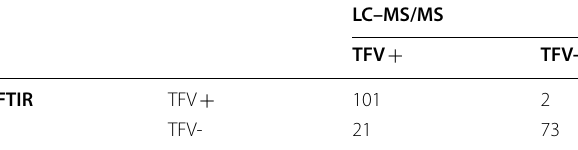
Table 4 Agreement between FTIR‑based predictions and